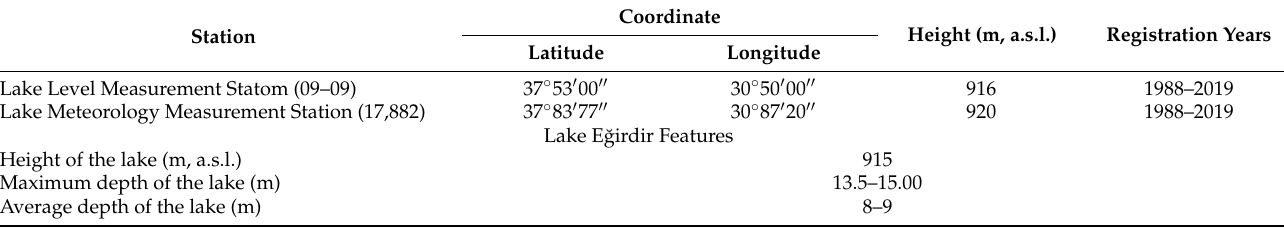
Table 1. Features of Lake Eğirdir and the measurement station.